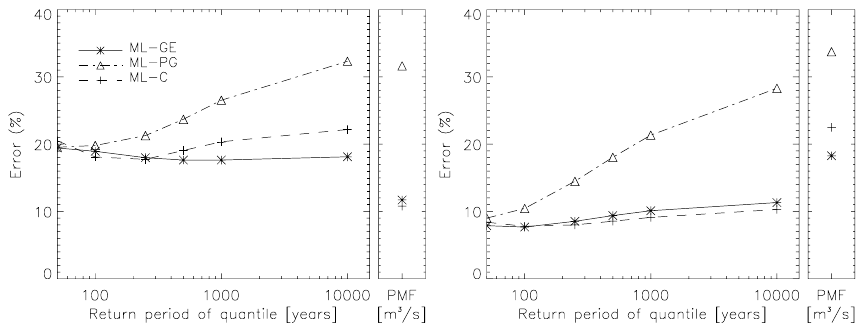
Fig. 4. Estimation error (in %) of ˆ q T and ˆ g (PMF estimate). H = 50, M = 400 and N = 50 years. Left: scenario 1, right: scenario 2.